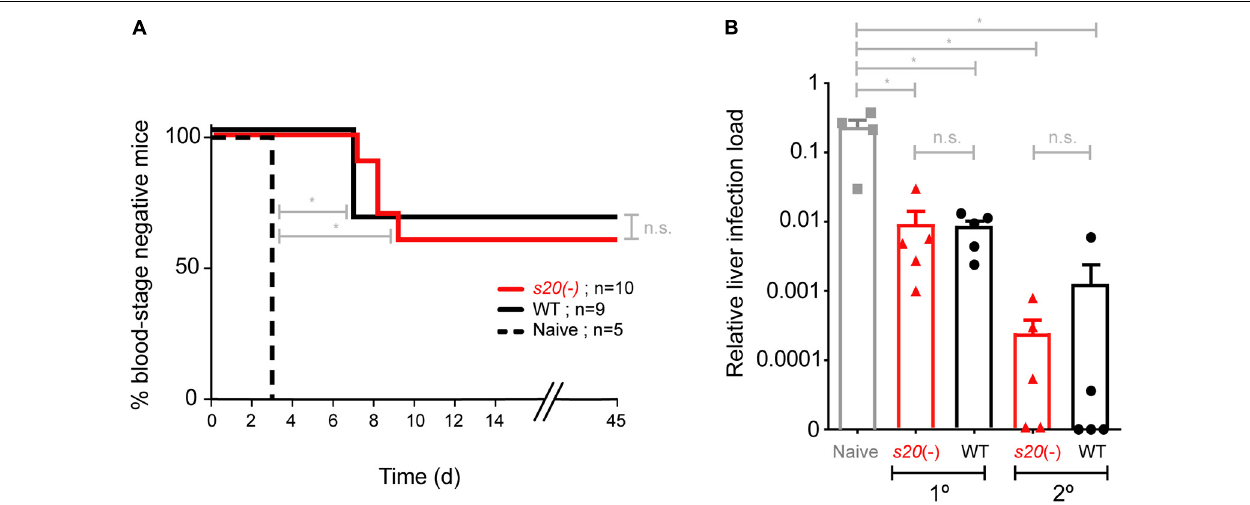
FIGURE 4 | Loss of S20 does not affect vaccine-induced protection. (A) Immunization and challenge protocol. Groups of B6 mice were immunized twice with 10,000 s20 (-) ( n = 10) or WT γ -sporozoites ( n = 9) and challenged 35 days after the last immunization by intravenous injection of 10,000 WT sporozoites. Naïve mice ( n = 5) served as a control. Shown is a Kaplan-Meier analysis of time to blood infection after challenge infection. From day 3 onward mice were monitored daily for blood stage parasitaemia by microscopic examination of Giemsa-stained blood films. n.s., non-significant; * p < 0.05 (Mann Whitney U test). (B) Protective efficacy as measured by qRT-PCR. S20 (-) and WT single or double immunized were challenged with 10,000 infectious sporozoites ( n = 5 each). Naive mice ( n = 4) served as controls. The relative liver load was determined 42 h later after liver removal, RNA extraction and qRT-PCR with Pb 18S rRNA primers normalized to mouse GAPDH. Shown are mean values ( ± SEM); n =